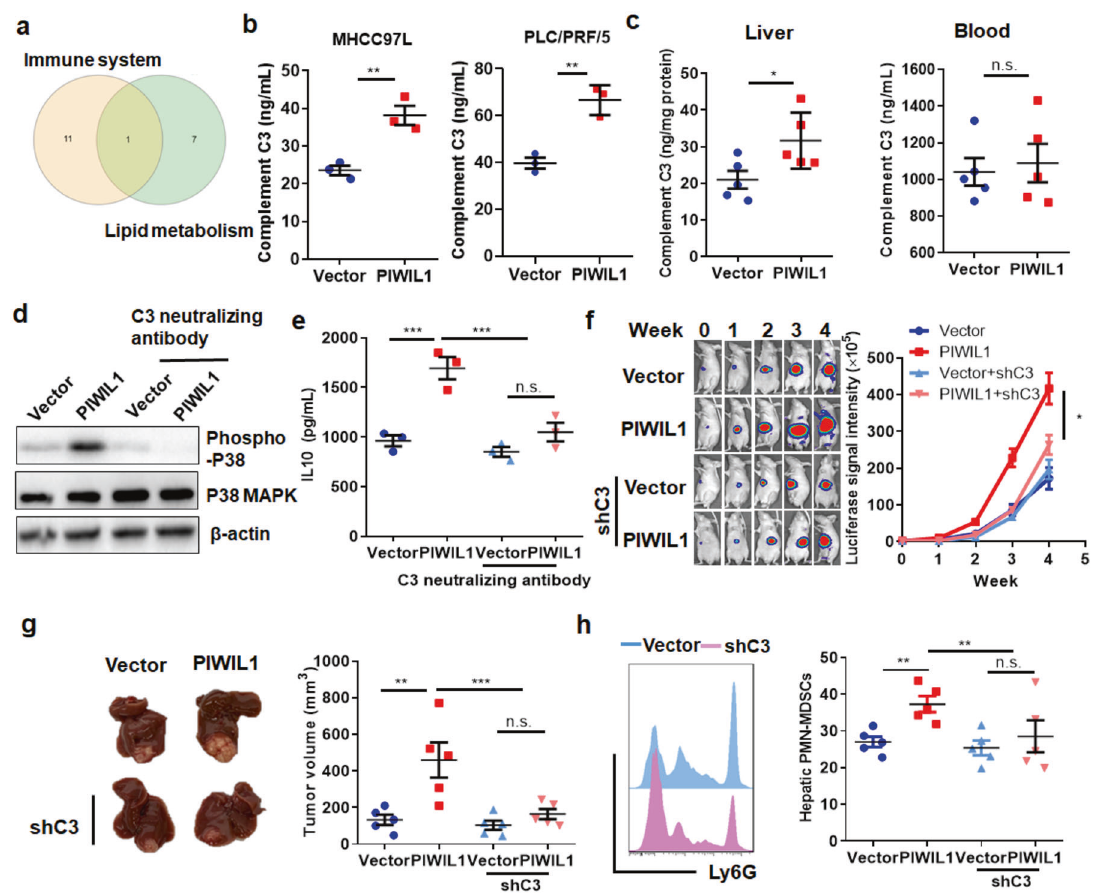
clusters; b the secretion of complement C3 was measured in wild type and PIWIL1-overexpressing HCC cells, which showed that PIWIL1 overexpression could remarkably induce C3 secretion in HCC cells; c Complement C3 level was also then measured in the circulating blood and surrounding hepatic tissues of mice with wild type or PIWIL1-overexpressing HCC. Increased complement C3 level in surrounding hepatic tissues but not circulating blood of mice with PIWIL1-overexpressing HCC was observed. The BMDMs were isolated using fi coll method, and cultured with 50% conditioned medium from PIWIL1-overexpressing HCC cells for 4 days in the presence of neutralizing antibodies against human complement C3 protein. Blockade of Complement C3 signi fi cantly reduced d the activation of p38 MAPK and e secretion of IL10;